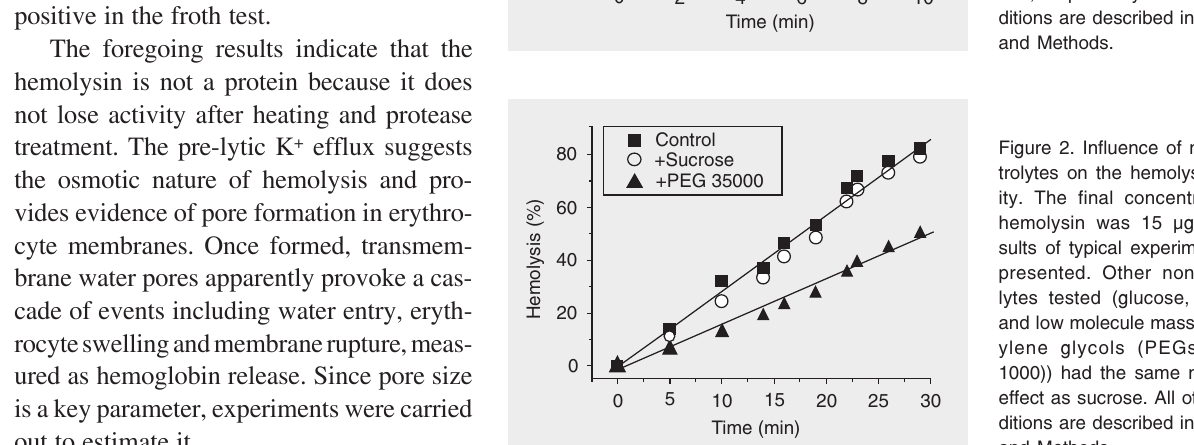
Figure 1. Time course of hemo- lysis in response to the addition of 30 µg/ml Passiflora quadran- gularis hemolysin. Squares = original preparation of hemoly- sin, circles = hemolysin pre- treated with trypsin. Data are re- ported as the mean ± SD for at least 4 experiments. The time requirement for 50% erythrocyte lysis (T 50% ) was equal to 2.5 ± 0.1 min and 1.5 ± 0.1 min for the original preparation of hemoly- sin and for the trypsin-treated one, respectively. All other con- ditions are described in Material and Methods.